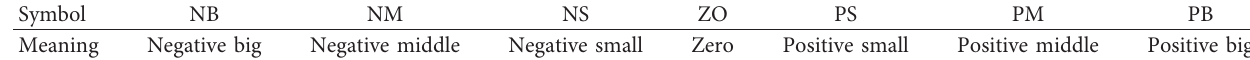
Table 1: Representation meaning of parameters in fuzzy sets.